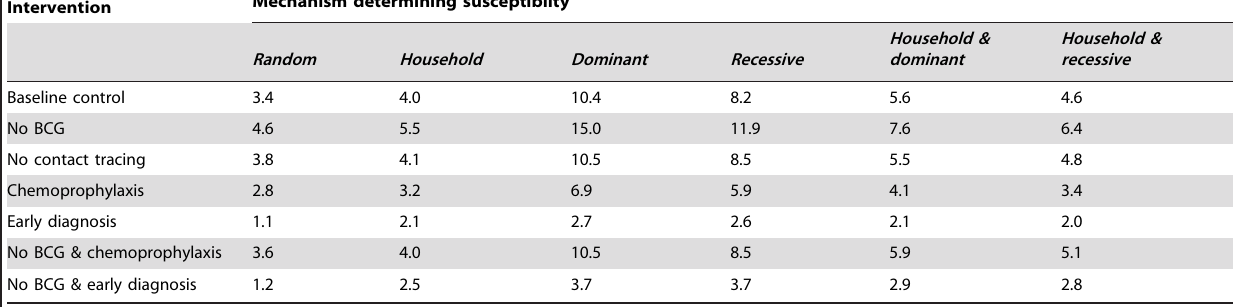
Table 1. Predicted new case detection rates (per 100,000) at 25 years after the introduction of the indicated intervention scenario for six mechanisms of leprosy susceptibility as described in [9].